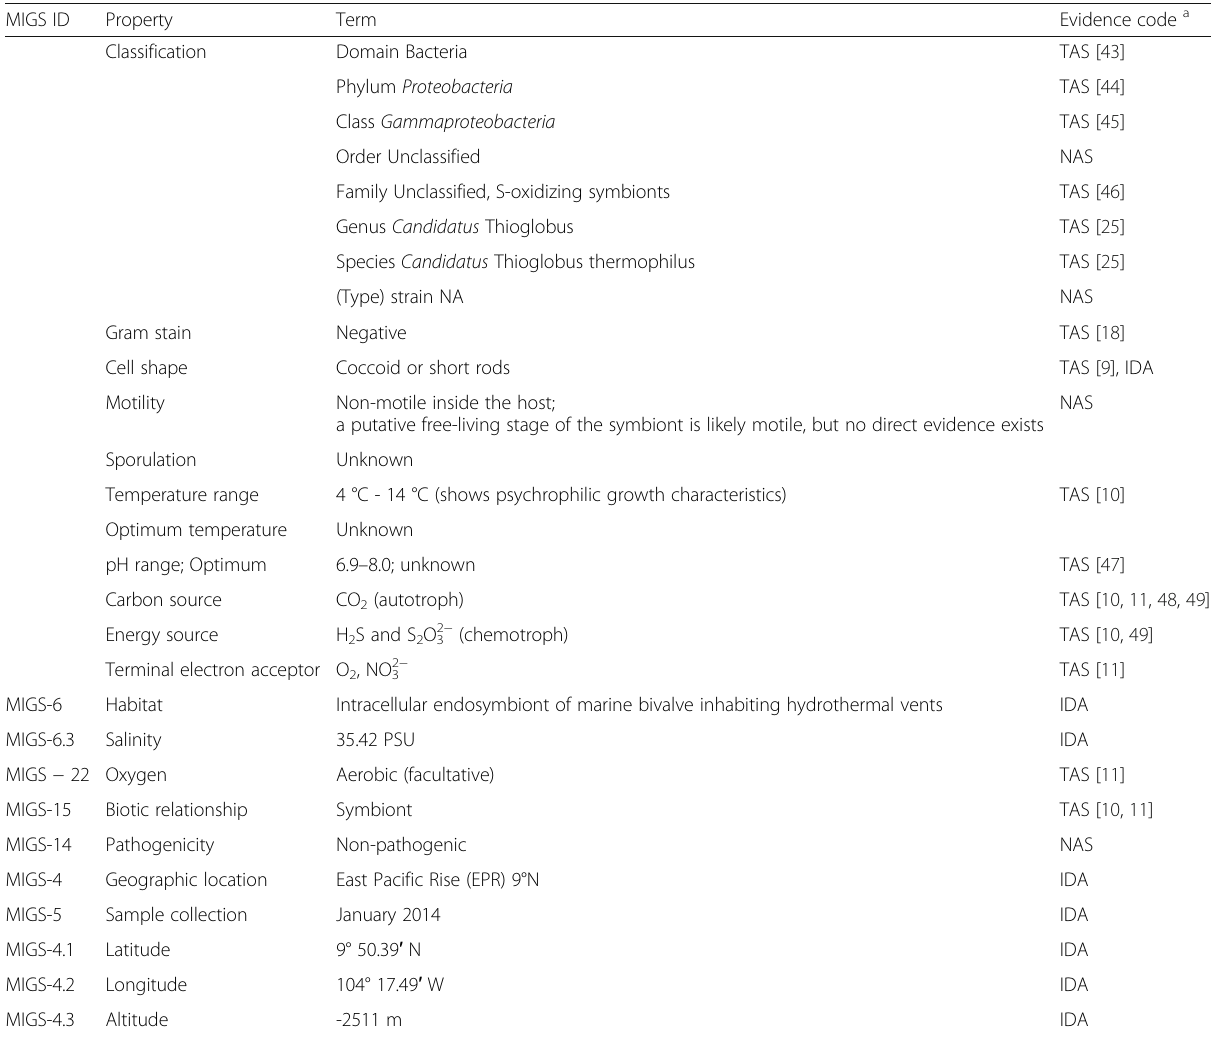
Table 1 Classification and general features of Candidatus Thioglobus thermophilus, the Bathymodiolus thermophilus gill endosymbiont, according to the MIGS recommendations